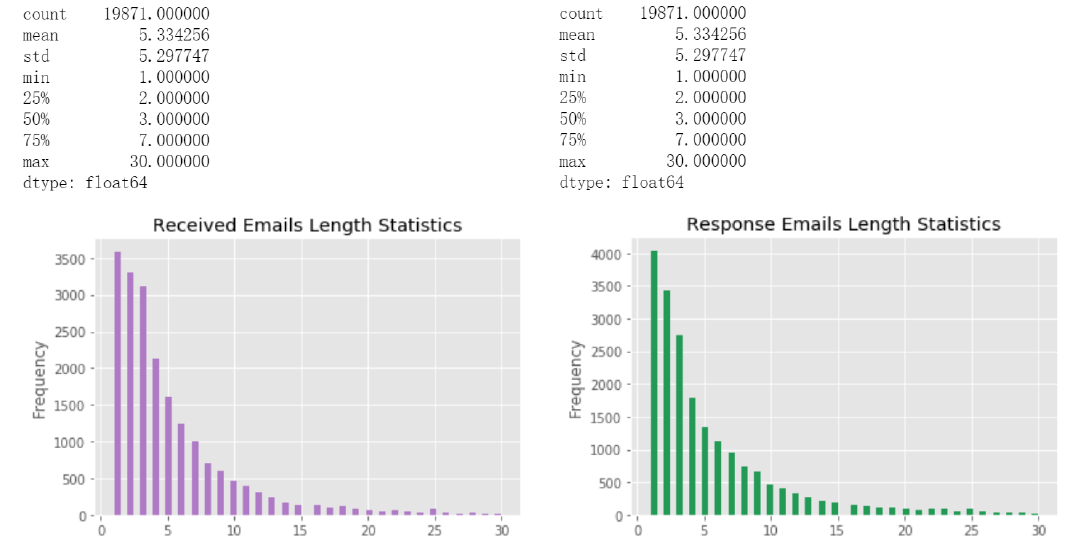
Figure 8. Processed E-mail Content Length Statistics.